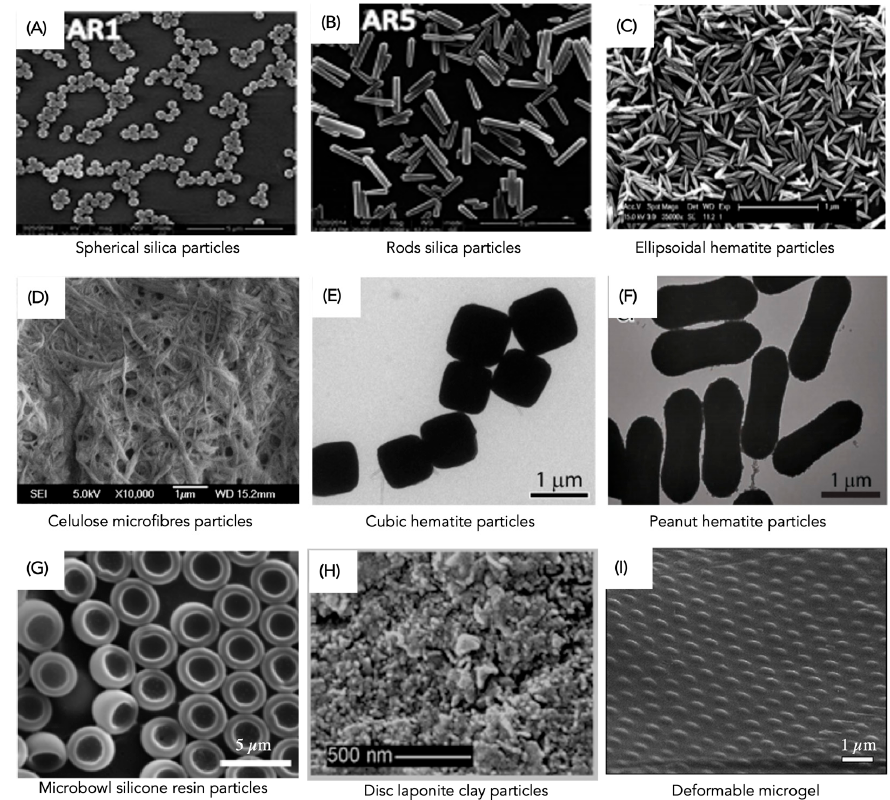
Figure 3. Different solid particle shapes. ( A ) spherical [31], ( B ) rods [31], ( C ) ellipsoidal [61], ( D ) microfibres [62], ( E ) cubic [63], ( F ) peanut [63], ( G ) microbowl [64], ( H ) disc [65] and ( I ) deformable